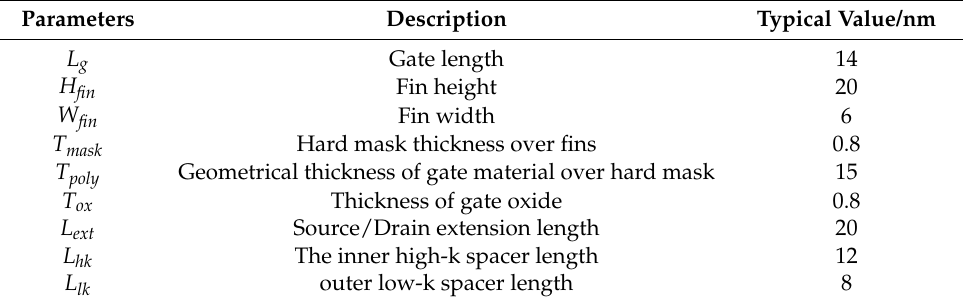
Table 1. Nominal device parameters.